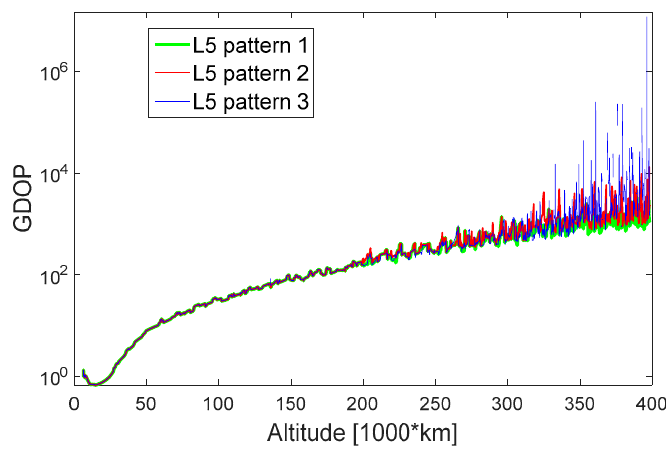
Figure 25. GDOP in log scale during the assumed MTO.